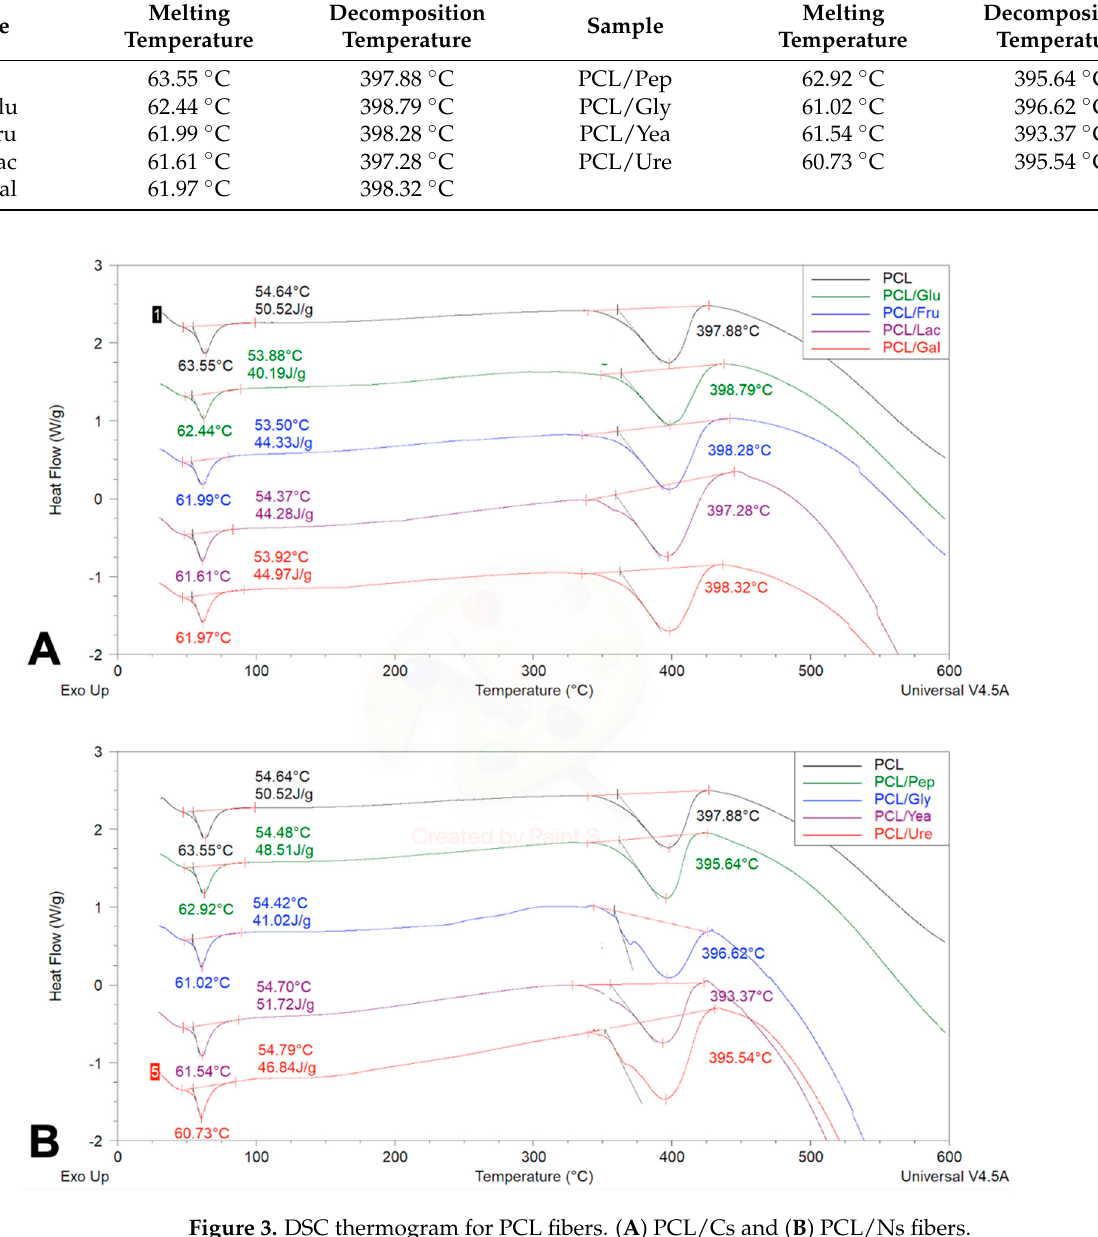
Figure 3. DSC thermogram for PCL fibers. ( A ) PCL/Cs and ( B ) PCL/Ns fibers.